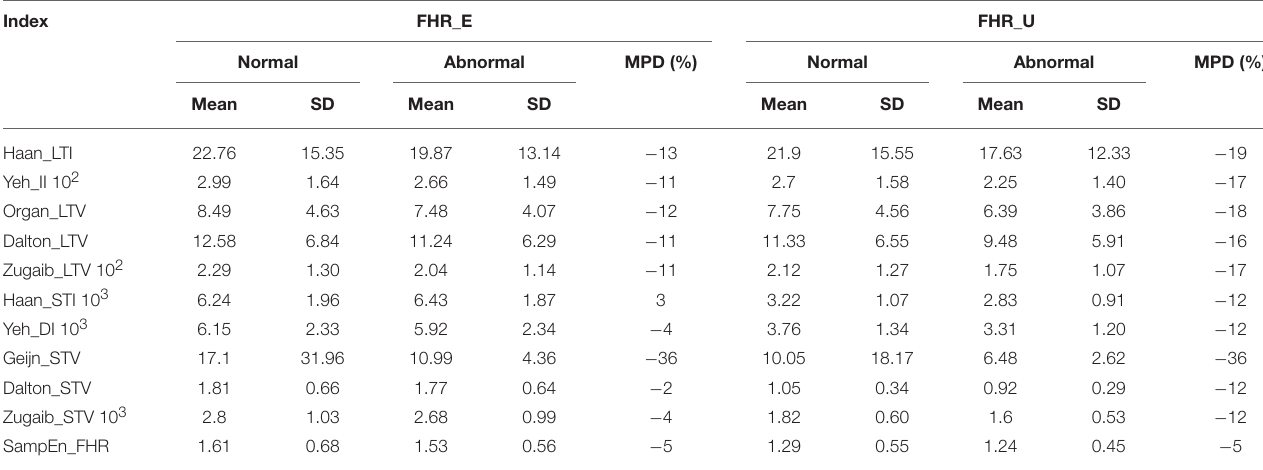
TABLE 6 | Results of the FHR_E and FHR_U signal analysis, in terms of the instantaneous FHR variability assessment, calculated for signal in a form of time event series, together with the mean percentage difference MPD depicting the inconsistencies between both the